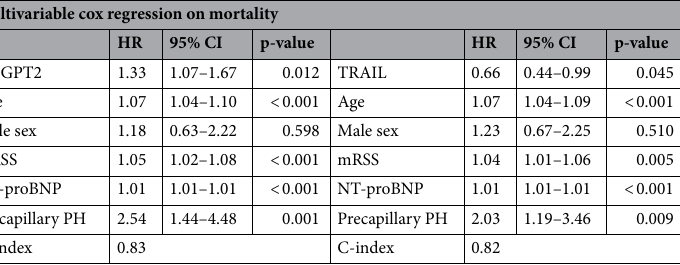
Table 4. Prediction of mortality by ANGPT2 and TRAIL in multivariable cox regression. ANGPT2 angiopoietin 2, CI confidence interval, HR hazard ratio, mRSS modified Rodnan skin score, NT-proBNP N-terminal prohormone of brain natriuretic peptide, PH pulmonary hypertension, TRAIL tumor necrosis factor-related apoptosis-inducing ligand. The HR of ANGPT2 and TRAIL represent an increase of one standard